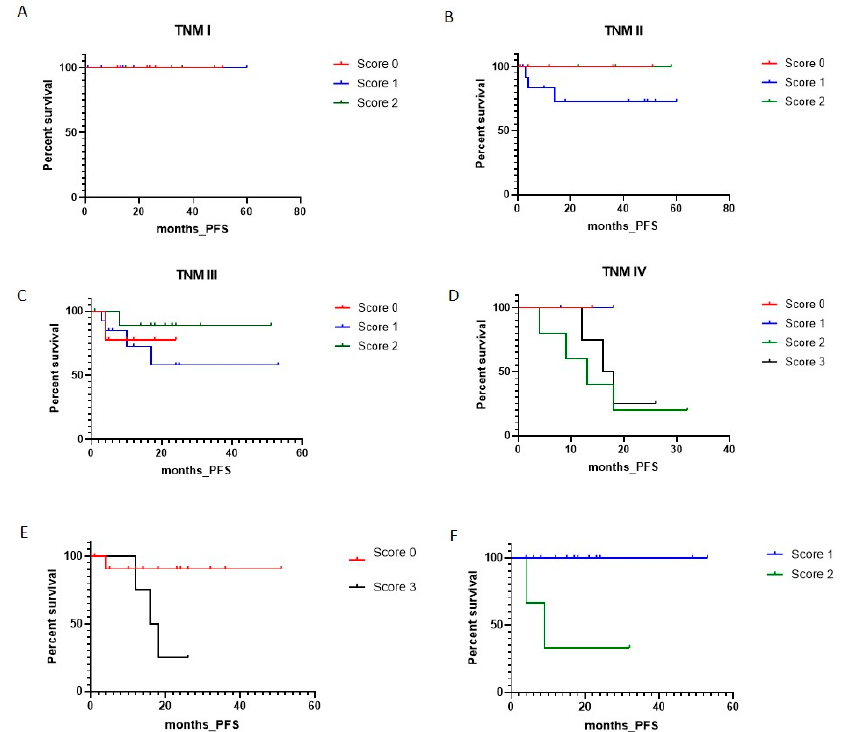
Figure 2. Kaplan-Meier plots of PFS comparing different nNav1.5 scores. ( A – D ), all scores in the four TNM stages. ( E ), score 0 vs. score 3 in all TNM stages. ( F ) score 1 vs. score 2 in left colon. Score 0: red curves; Score 1: blue curves; Score 2: green curves; Score 3: black curves.